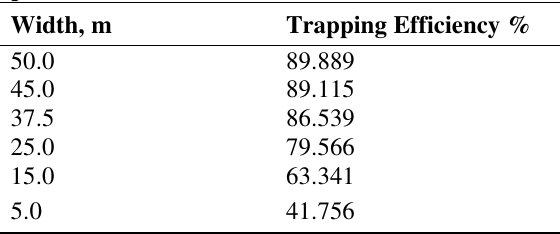
Values of VFS width and trapping efficiency